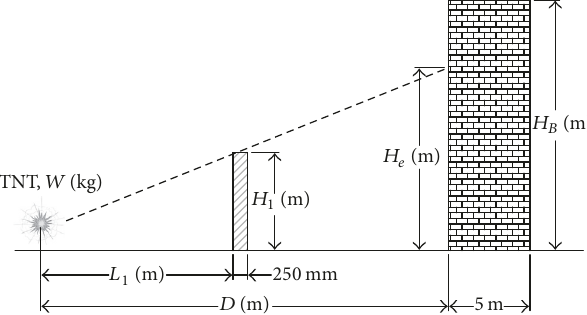
Figure 10: Detail of explosive placement, barrier wall, and target